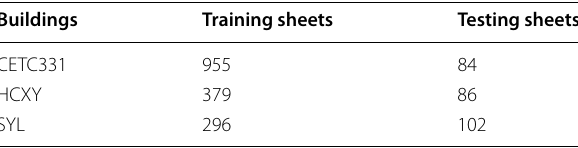
Table 4 Number of points in different sheets